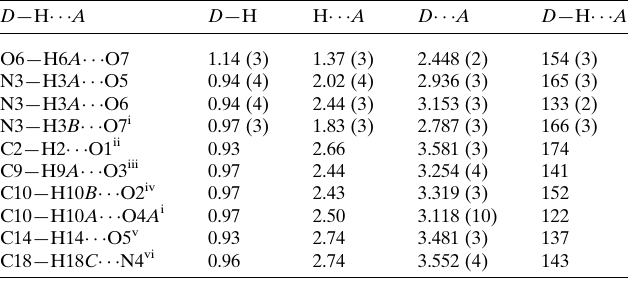
Table 1 Hydrogen-bond geometry (A˚ , (cid:4) ).